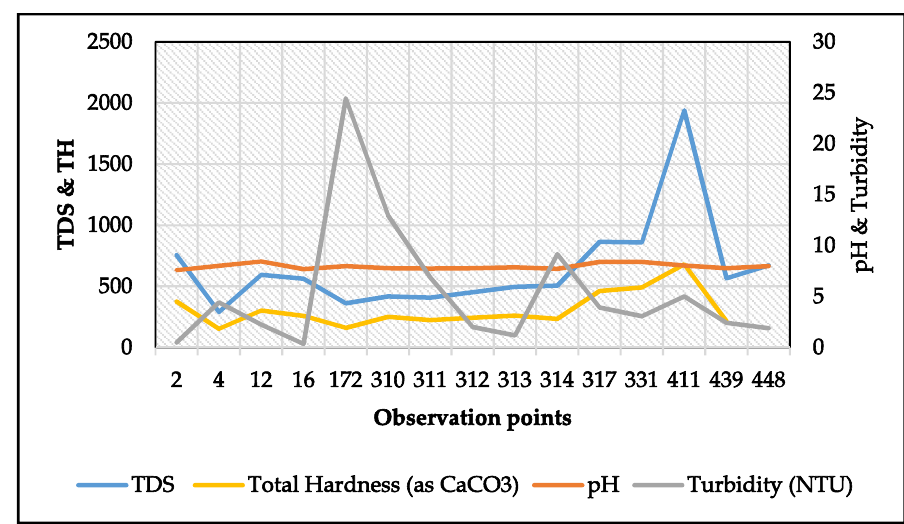
Figure 3. A comparison of total dissolved solids, total hardness, pH, and turbidity values in all studied points. Note: The TDS and TH unites are mg/L, turbidity is measured in NTU and pH is dimensionless.